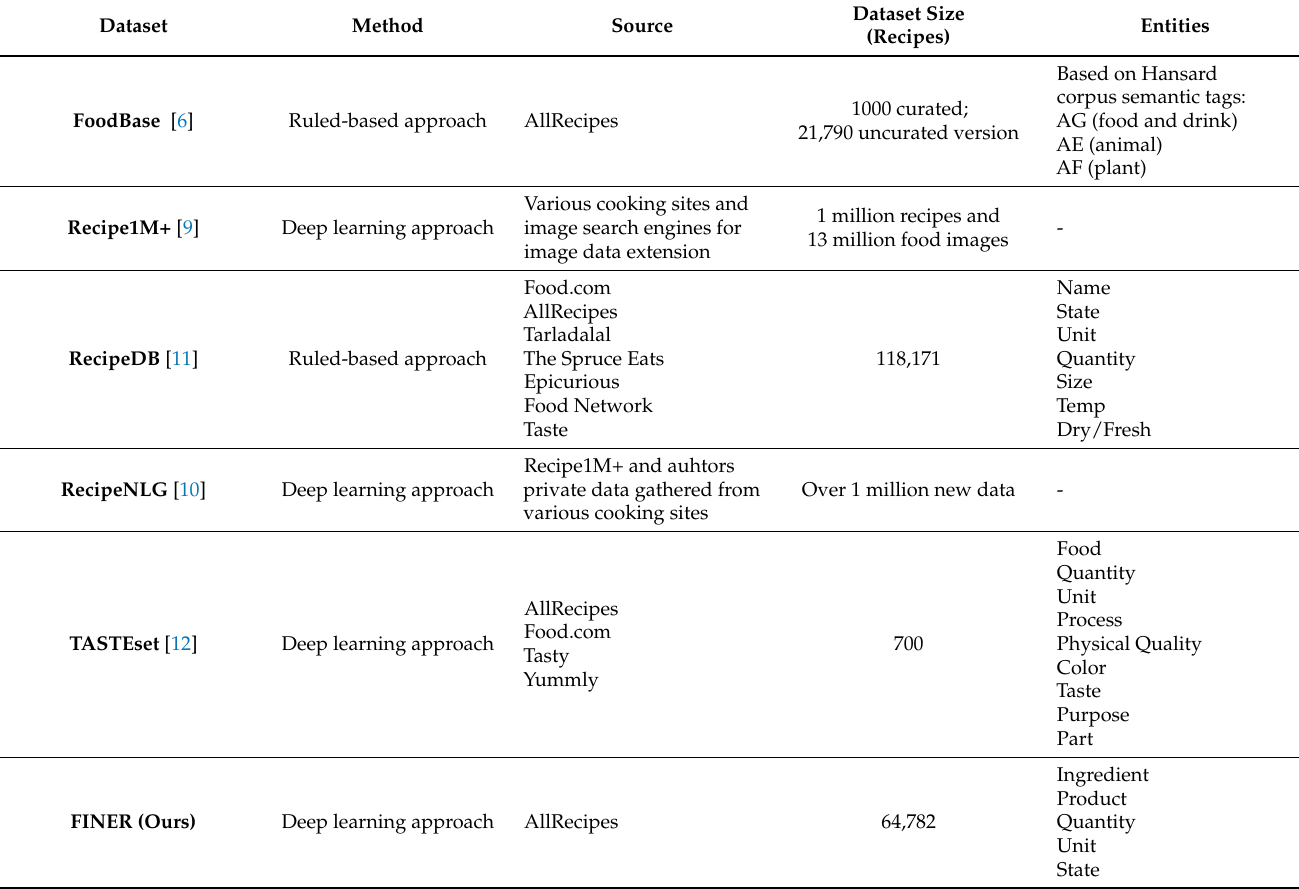
Table 1. Comparison of available food dataset to our FINER